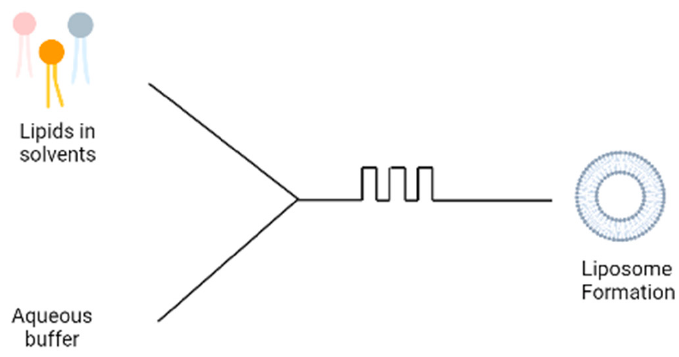
Figure 4. Schematic diagram of microfluidic technique.